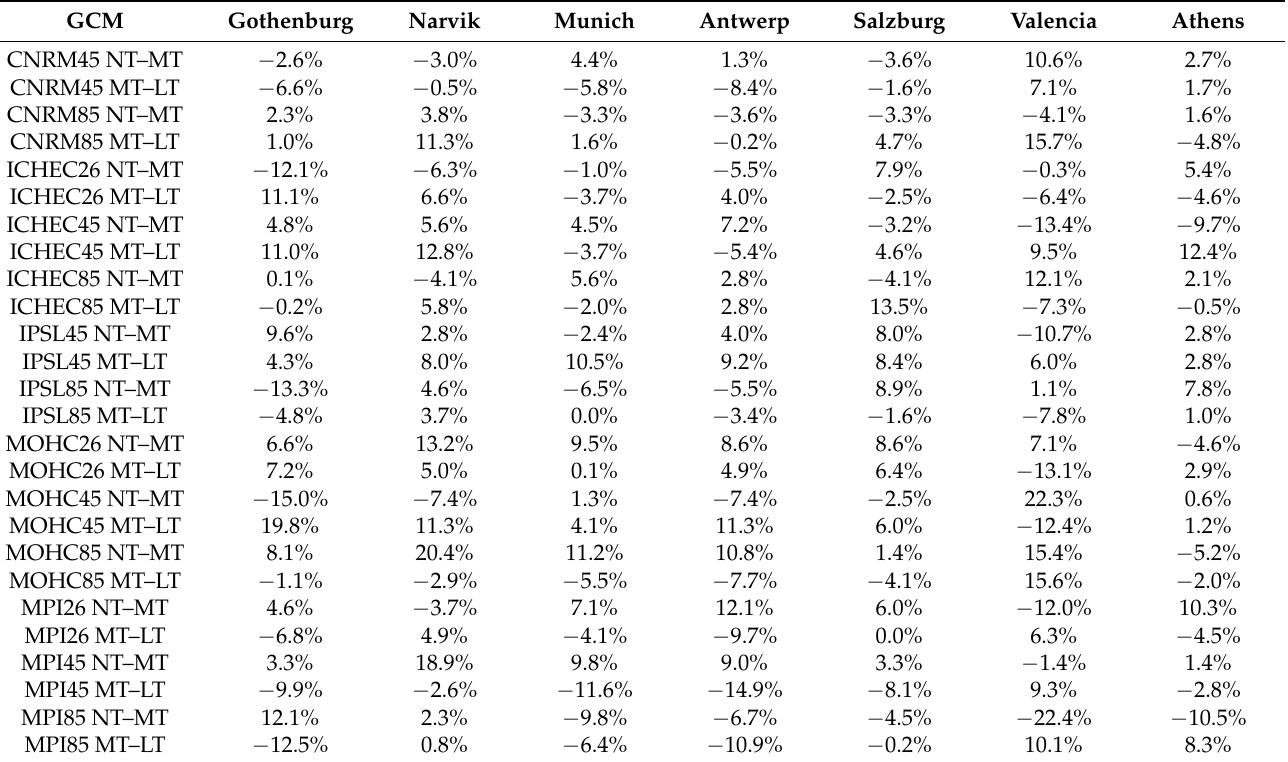
Table 3. Relative difference of NT–MT and MT–LT of winter wind turbine output for each climate